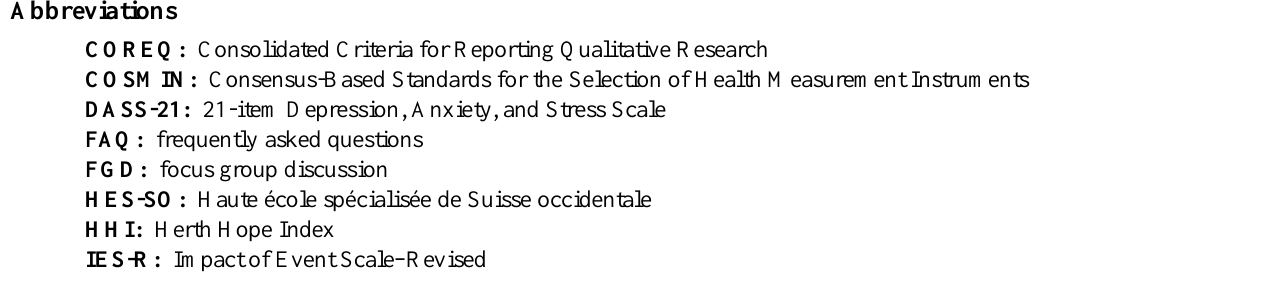
FAQ: frequently asked questions FGD: focus group